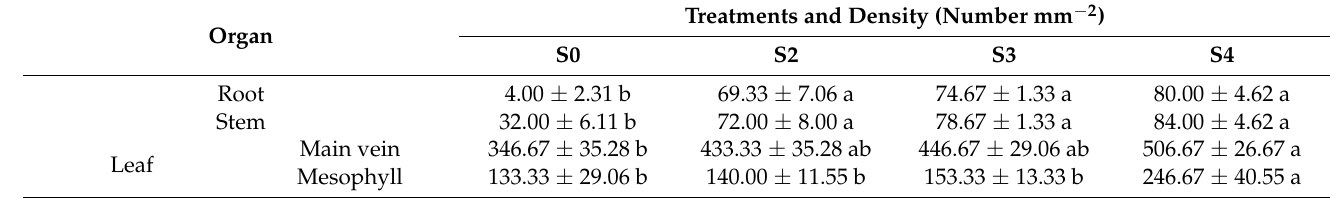
Table 7. Density of calcium oxalate crystals in various organs of C. elegans seedlings. Calcium oxalate crystals were counted in three visual fields for each treatment. S0, S2, S3, and S4 indicate control, 0.2%, 0.3%, and 0.4% salt concentration treatments, respectively. Values are the mean ± standard error. Values for each row in the same organ followed by different letters denote a significant difference among different treatments according to Duncan’s new multiple range test ( p <